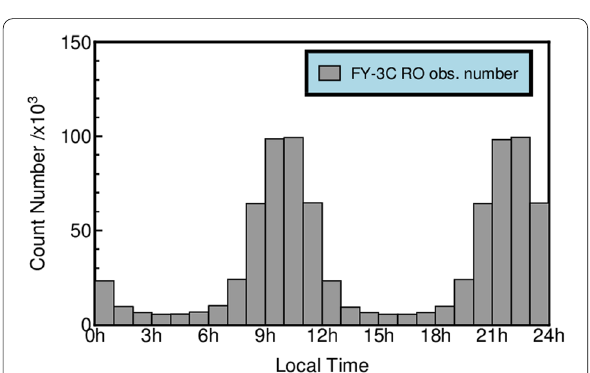
Fig. 7 The local time distribution of FY-3C GPS RO events number during Jan. 2015 to Dec